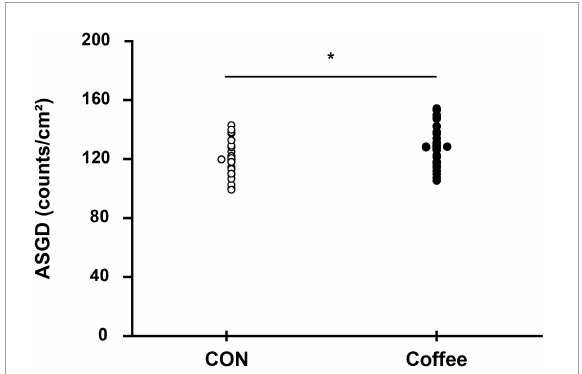
FIGURE4 Comparison of sweating activity gland density between subjects in the CON and Coffee groups. Statistical significance difference, * p < 0.05. CON, no coffee group ( n = 40); Coffee, coffee intake group ( n = 40); ASGD, activated sweat gland density.